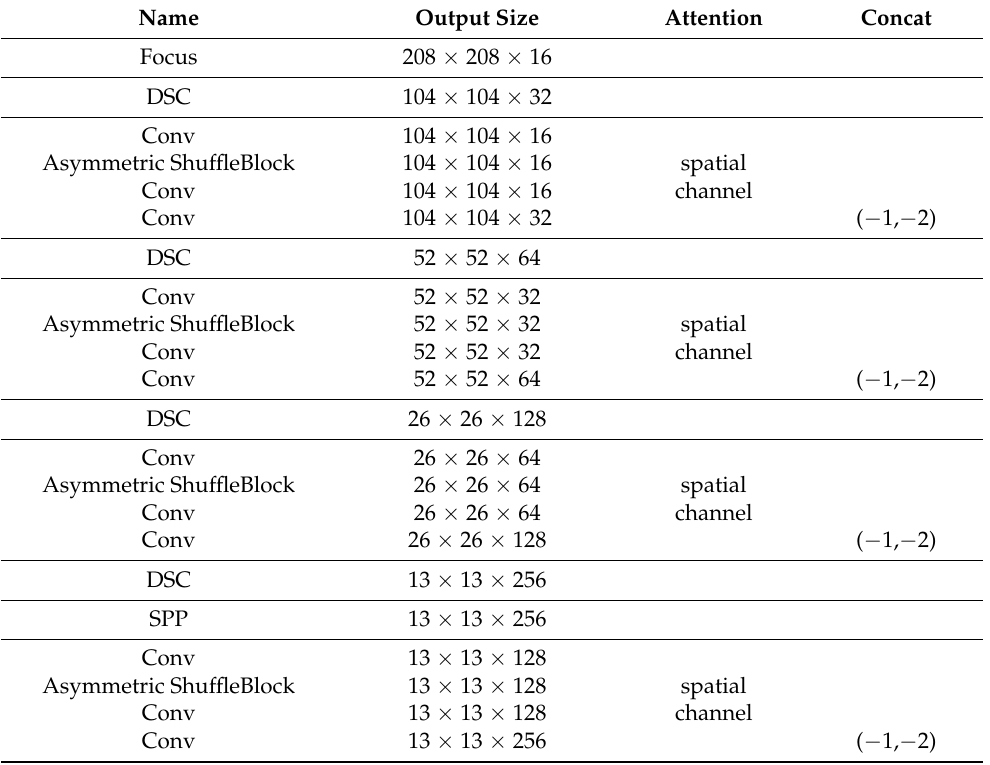
Table 2. The backbone network structure of